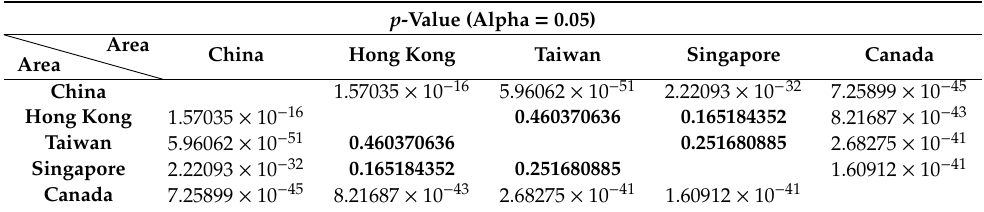
Table 2. p -value of every two areas on to-date mortality rate.